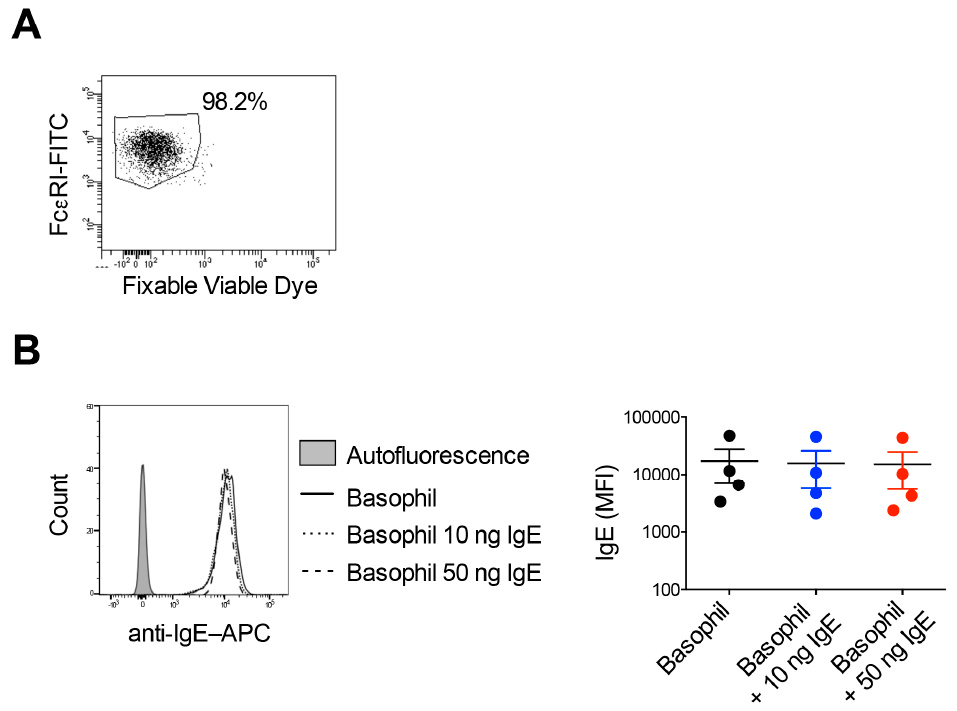
Figure 1. Fc ɛ RI on basophils are almost saturated with IgE. ( A ) The viability of isolated basophils as analyzed by fixable viable dye staining. ( B ) Peripheral blood basophils were incubated with extrinsic amounts of IgE (10 ng or 50 ng / million cells) for 30 min and followed by surface staining for IgE on the basophils. The intensity of IgE binding on the basophils was analyzed by flow cytometry. Representative histogram overlays (left panel) and the intensity of IgE on the surface of basophils as represented by MFI values (Median fluorescence intensity, mean ± SD, n = 4 donors) (right panel).